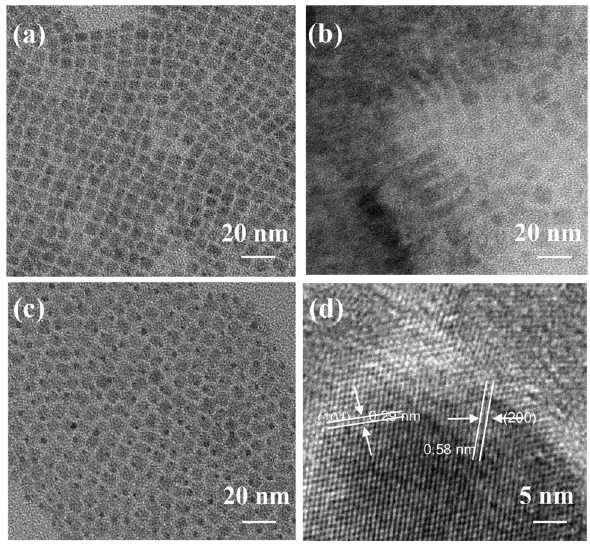
Fig. 2 HRTEM images of samples a CsPbBr TiO